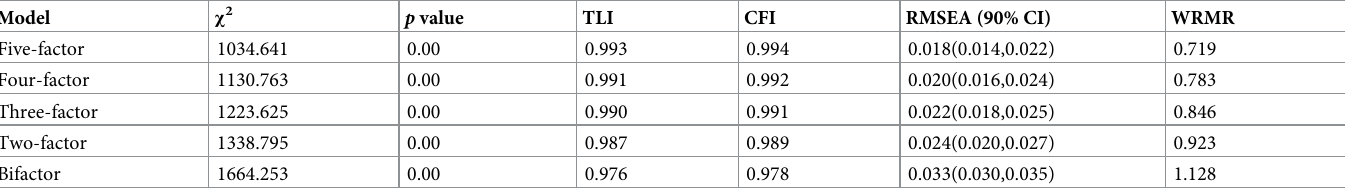
Table 3. Summary of fitting indexes of OCD-trait screening scale (models).